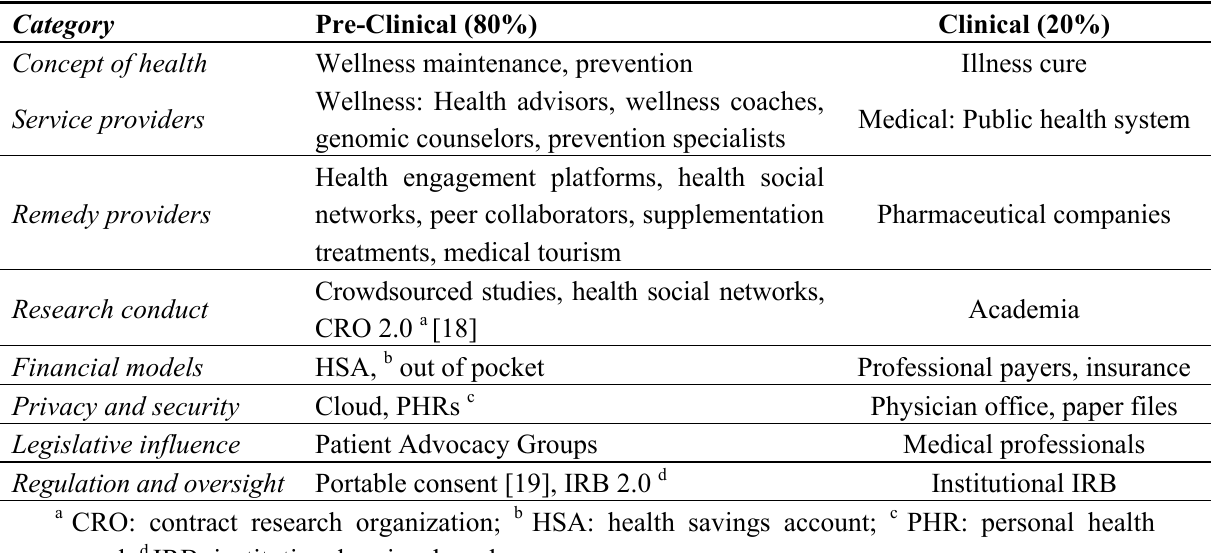
Table 1. The 80/20 Model: Addressing and eliminating conditions while still